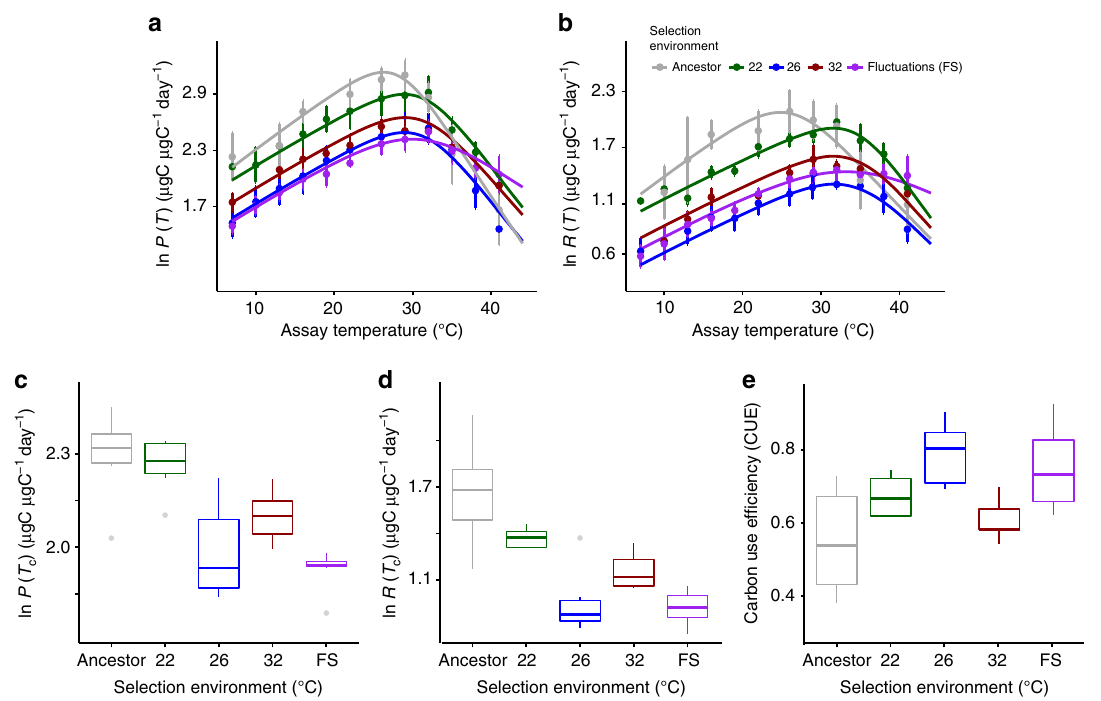
Fig. 2 Rapid evolution of metabolic traits increase carbon-use ef fi ciency (CUE). a Thermal response curves for gross photosynthesis rates ( P ), and b respiration ( R ) reveal substantial shifts in metabolic thermal traits among treatments, as well as between the evolved lineages and the ancestor. Data are presented as means with error bars denoting ± 1 s.e.m, n = 6 per assay temperature, fi tted lines are fi xed effects from nonlinear mixed effects models. Mass-speci fi c rates of c gross photosynthesis and d respiration at a reference temperature ( P ( T c ) and R ( T c ) respectively, see Methods) were signi fi cantly down-regulated in the populations evolved under moderate, severe, and fl uctuating warming. Furthermore, rates of R ( T c ) were down-regulated more than those of P ( T c ) in the moderate and fl uctuating warming treatments meaning that e those lineages also had the highest CUE. Gray denotes the ancestor, green is the control at 22 °C, blue is at 26 °C, red is at 32 °C, and purple is the fl uctuating environment (FS). CUE for FS is displayed at 32 °C for easier comparison to the 32 °C-evolved samples, and did not differ signi fi cantly between assay temperatures of 22 °C, 26 °C, and 32 °C (see also Supplementary Figure 5). Whiskers on boxplots indicate 1.5 × interquartile